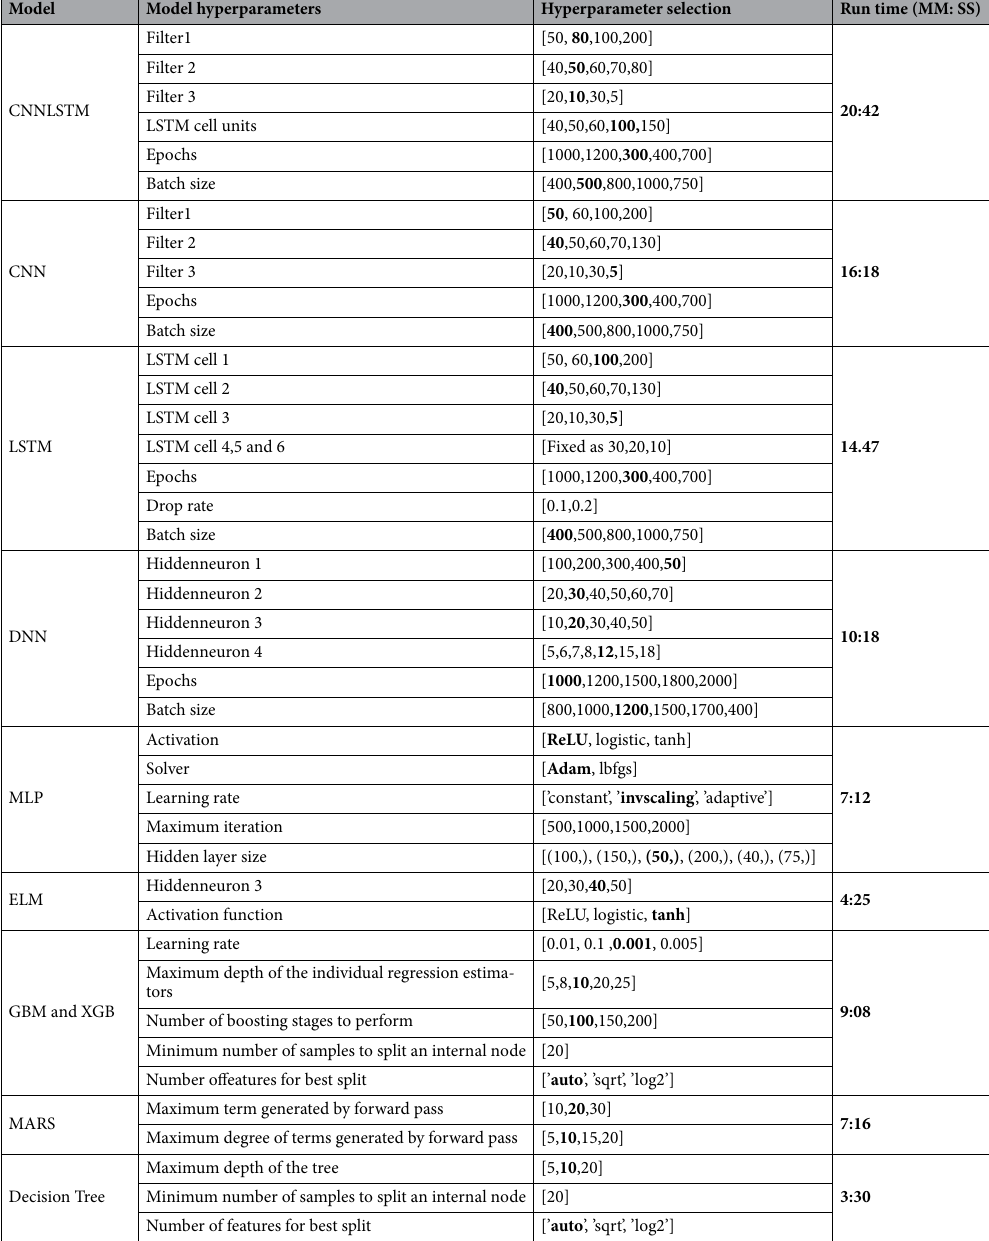
Table 2. The architecture of Deep learning models (Convolutional Neural Network (CNN) and CNNLSTM) and the respective conventional data-driven (MLP, ELM) and ensemble model (DT, GBM, XGB, MARS) used in the corresponding model development for Brisbane River and Teewah Creek streamflow ( Q , m 3 s −1 ) prediction, also the averaged training time for the optimum model is shown. ReLU, Adam and lbfgs stands for Rectified Linear Units, adaptive moment estimation and limited memory Broyden–Fletcher–Goldfarb–Shanno algorithm respectively. The selected parameter for the prediction of streamflow are bold